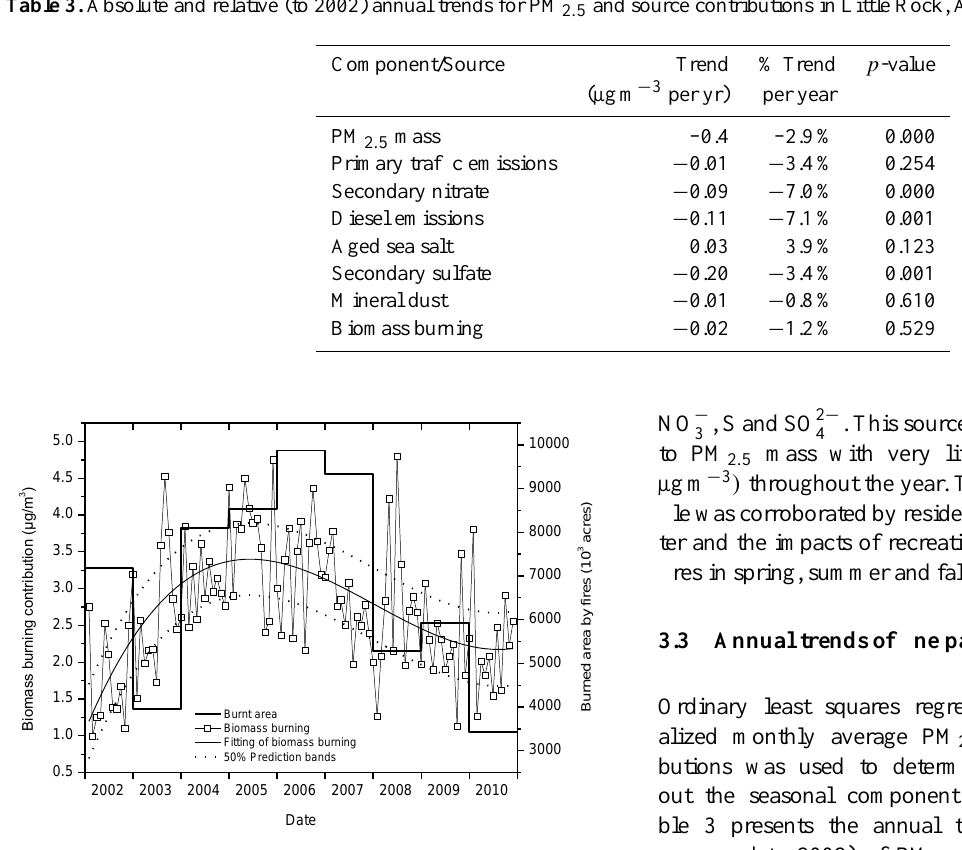
Fig. 5. Annual variation of PM 2 . 5 from biomass burning in Lit- Figure 5. Annual variation of PM 2.5 from biomass burning in Little Rock, Arkansas and burnt 2 tle Rock, Arkansas and burnt area by wildfires in the USA for the area by wildfires in the USA for the 2002-2010 period. 3 2002–2010